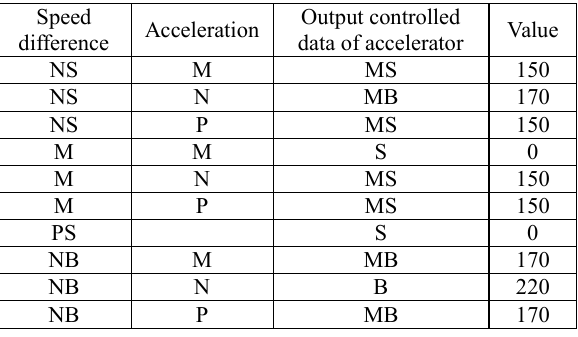
Table 3. Rulebase of accelerator